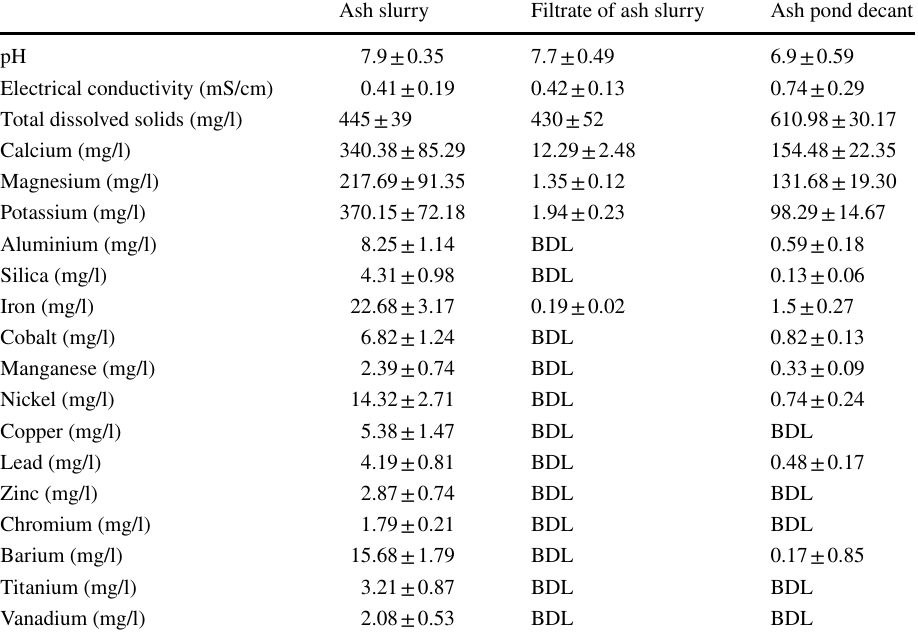
Table 1 Chemical properties of hydraulic transport water